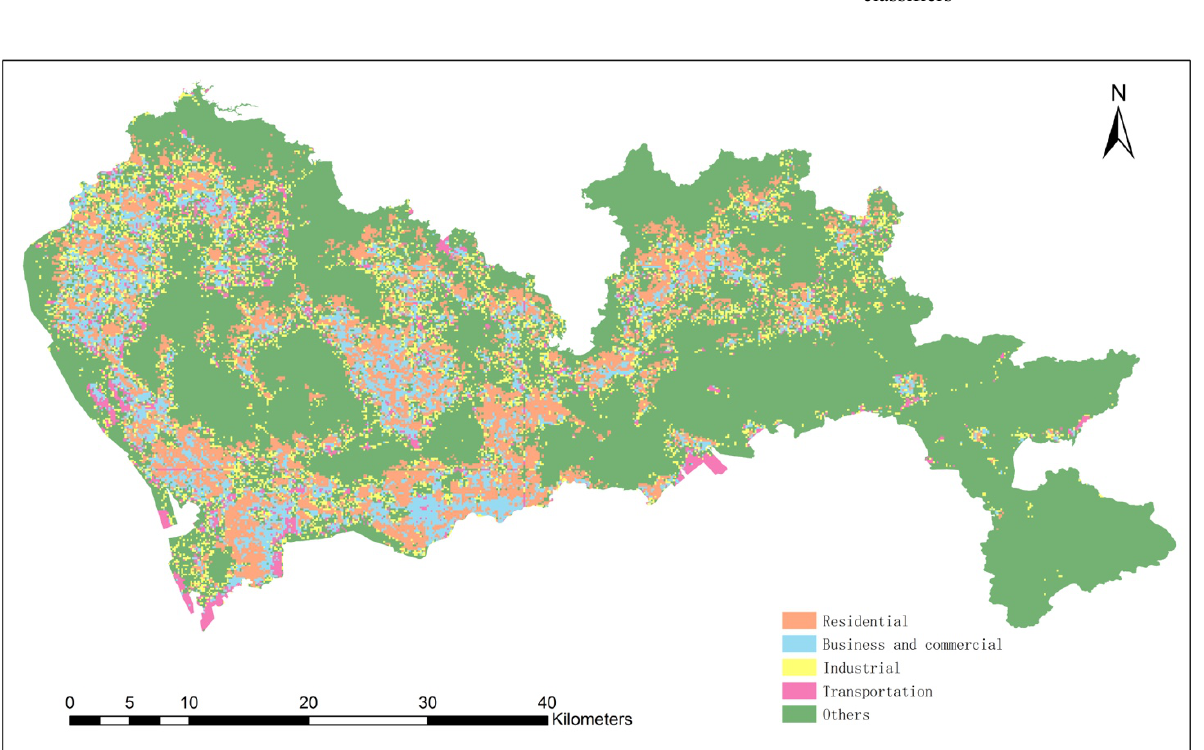
Figure 7. Classification results of functional regions in